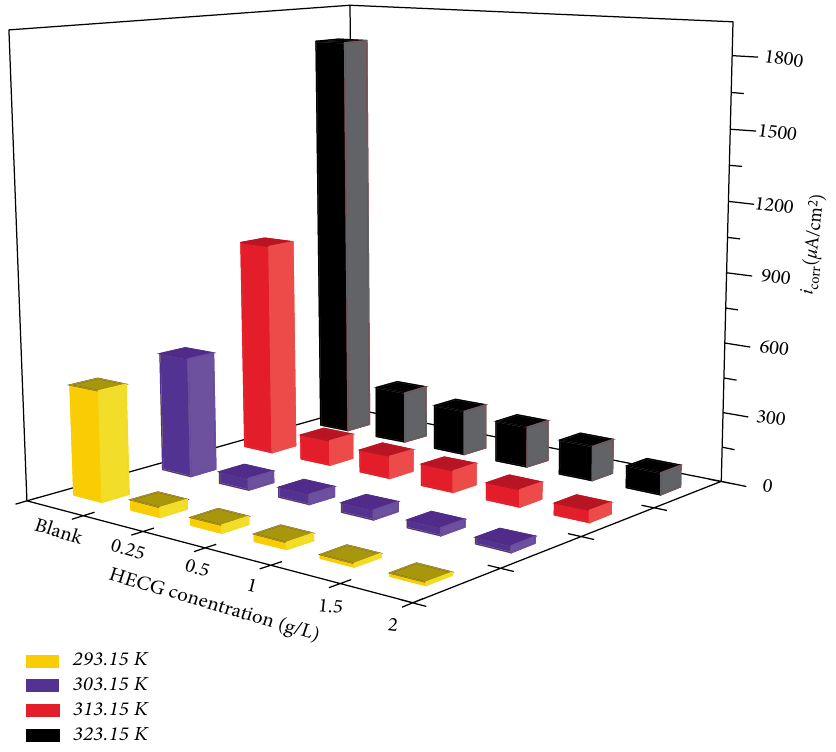
Figure 3: Variation of the corrosion current density with temperature and HECG